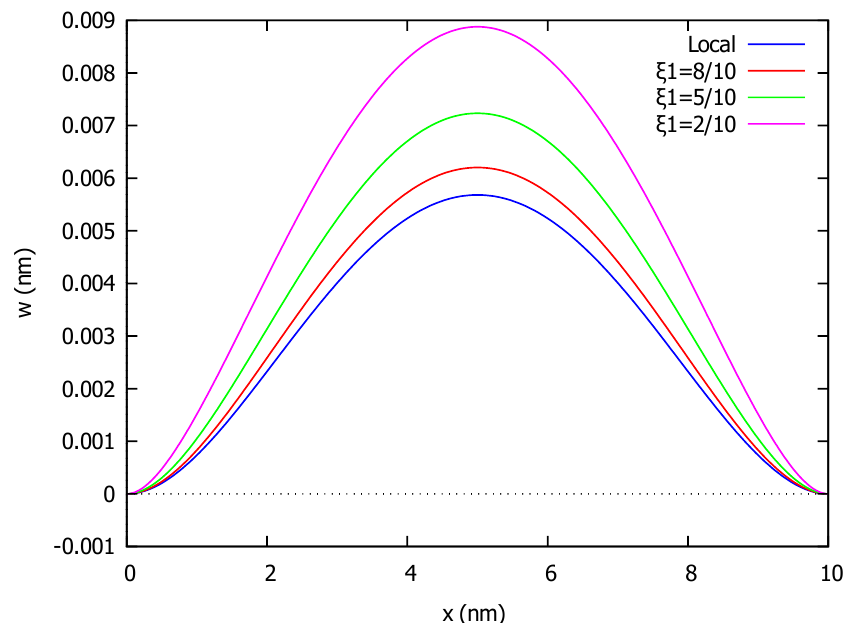
Figure 8. Deflection of clamped beam (CP) under uniform load and various values of ξ 1 .